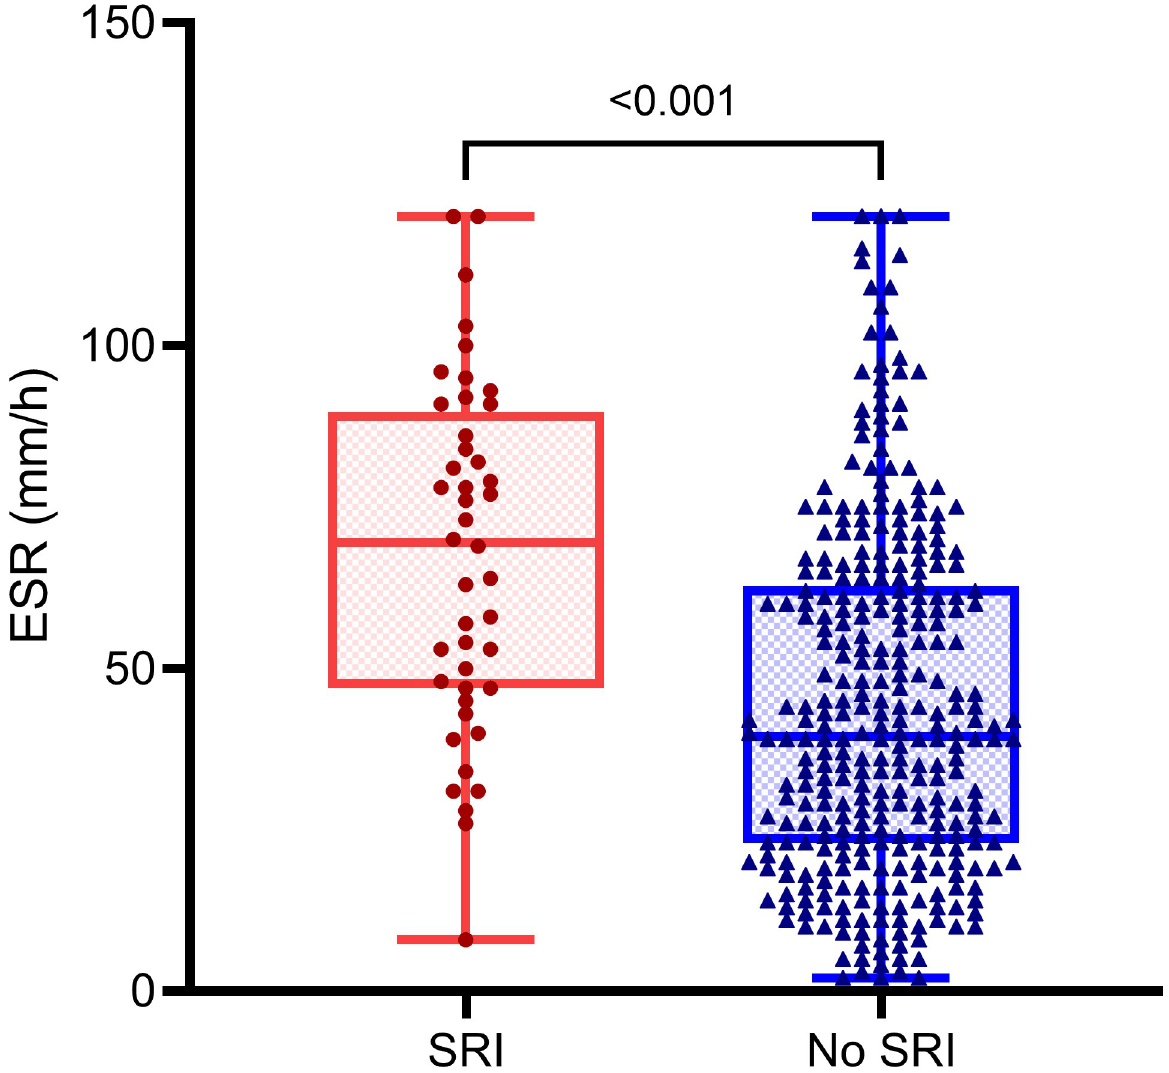
Fig 2. Box–Whisker plot of the difference in ESR between DFI patients with and without SRI. The graph presents the median, quartiles, and range of ESR in DFI patients with and without SRI. The red dots and blue triangles show all individual data points of two groups of patients. The median ESR of the 44 patients with SRI was 70mm/h (IQR, 47–90 mm/h); and the median ESR of the 320 patients without SRI was 40mm/h (IQR, 23–63 mm/h). There was a statistically significant difference between patients with and without SRI ( P < 0.001; Kruskal–Wallis H test). DFI, diabetic foot infection; ESR, erythrocyte sedimentation rate; IQR, interquartile range; SRI, severe renal impairment.